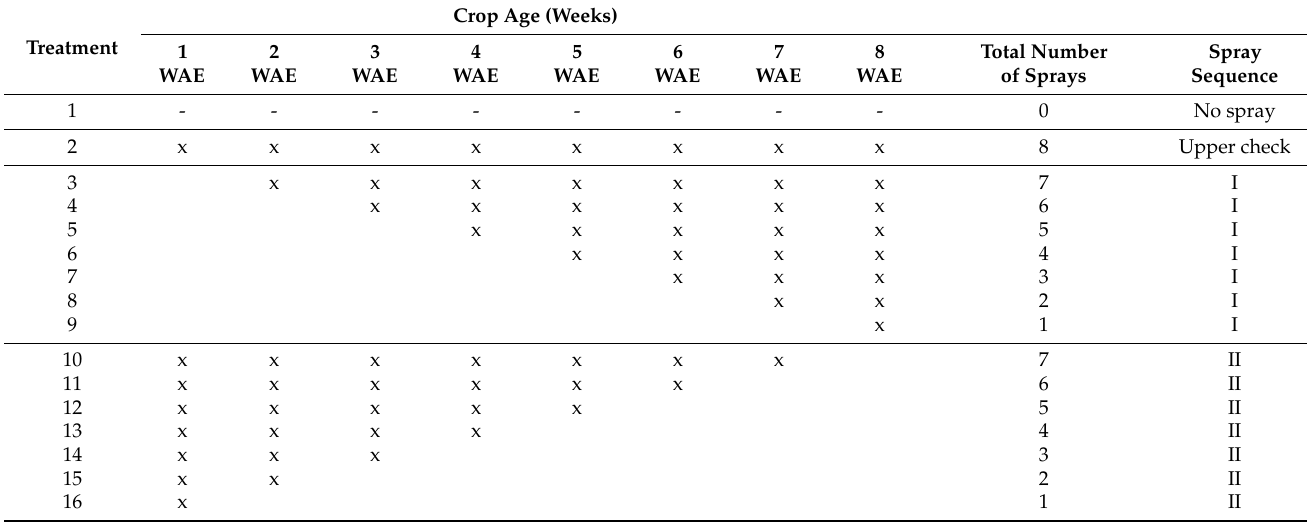
Table 1. Insecticide application schedule for control of fall armyworm on maize plants, from the seedling stage to tasselling, 8 weeks after seedling emergence in trials 1, 2 and 3. This spray schedule provided different periods of protection over different maize growing stages. The crosses indicate the time that insecticide applications were completed. WAE = weeks after seeding emergence. The onset of the tassel stage in trials 1 and 2 was at 8 WAE, and 9 WAE in trial 3.